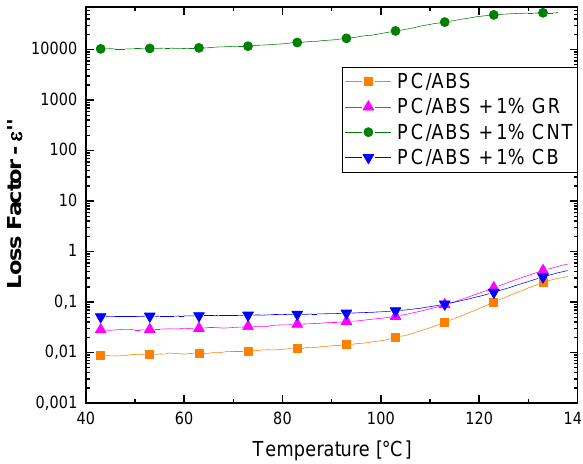
Figure 5. Comparison of loss factor curves of PC / ABS-based composites with 1 wt. % of filler content. Comparing the loss factor values of GR 1 wt. % samples obtained by extrusion and solution